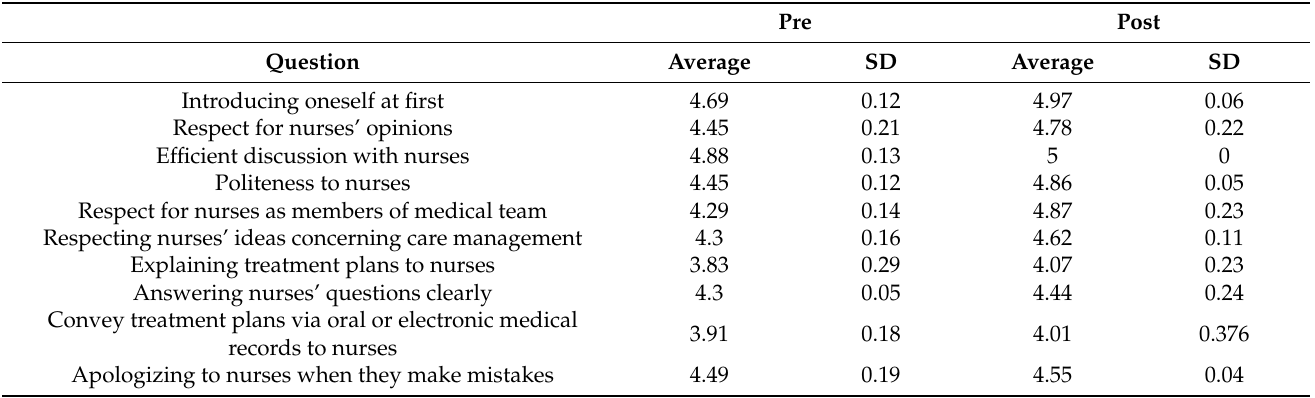
Table 2. Interprofessional collaboration